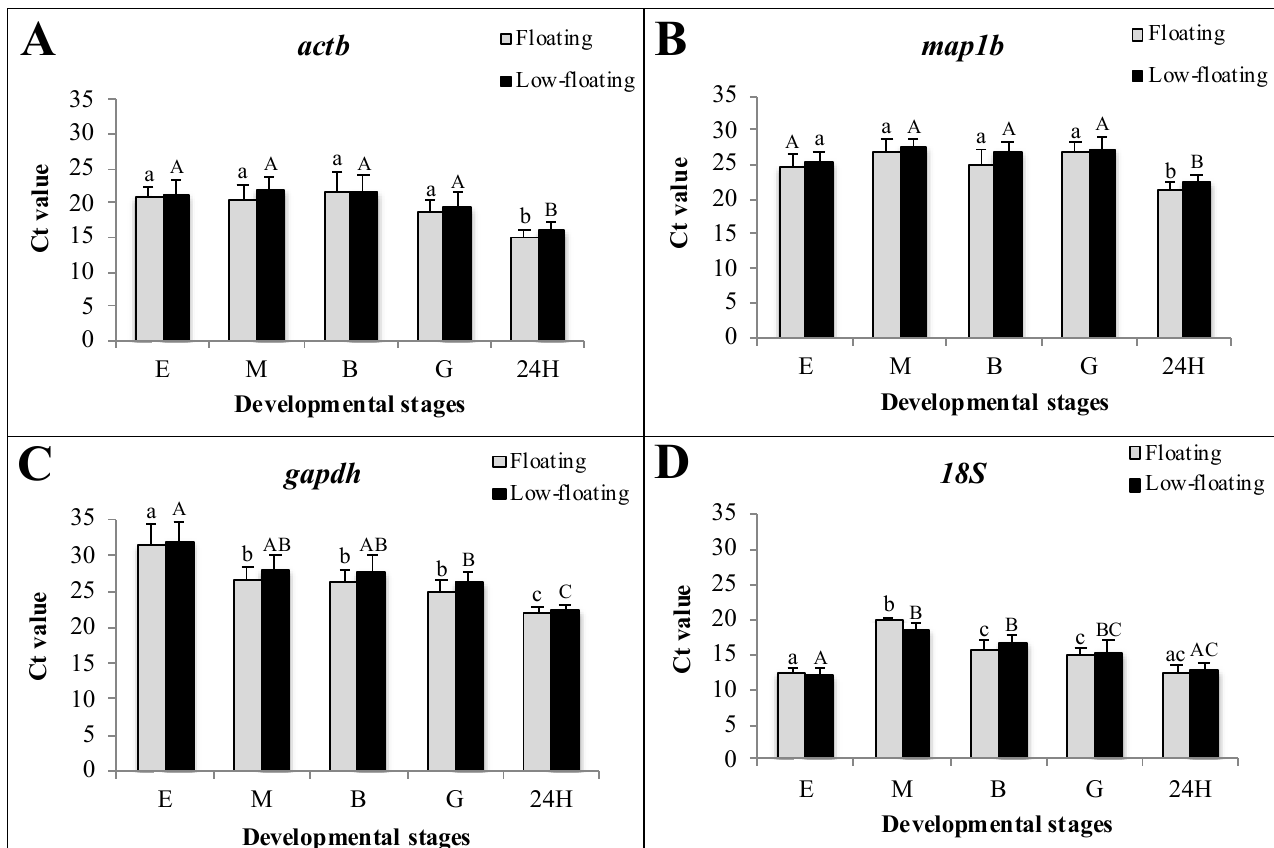
Figure 3. Transcriptional status of floating and low-floating embryos throughout development, assessed using the Ct value of four constitutive genes. Expression of actb, map1b, gapdh and 18S are showed in the graphs A, B, C and D, respectively. Fertilized eggs, morula, blastula and 24 h post-fertilization embryos are identified as E, M, B, G and 24H, respectively. Bars represent mean ± standard deviation (SD) of six biologicals replicates, and different lowercase or uppercase letters indicate statistically significant differences in floating or low-floating embryos, respectively ( p < 0.05).